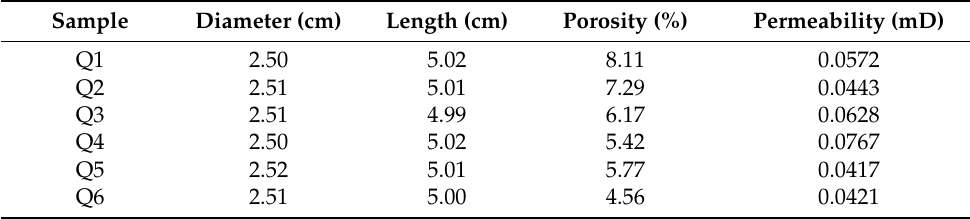
Table 3. Physical properties of shale